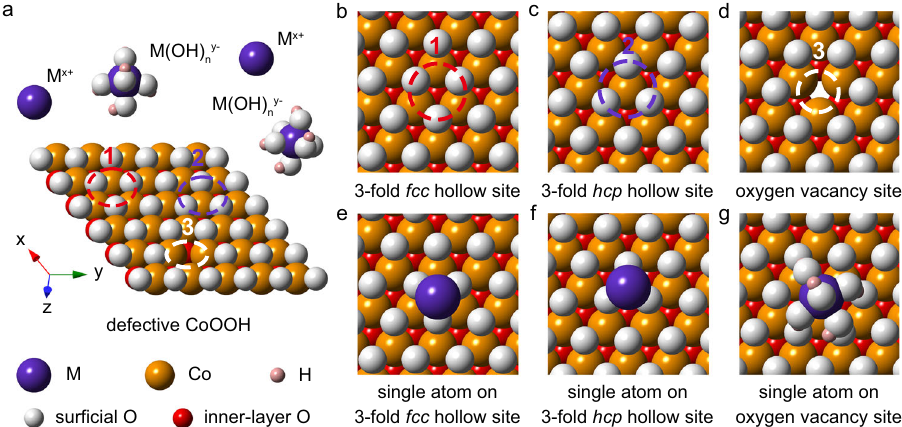
Fig. 1 Scheme of defective CoOOH surface for anchoring single atoms in alkaline solutions. a Oxygen-terminated (001) surface of defective CoOOH with oxygen vacancies. b – d Potential anchoring sites on defective CoOOH, including three-fold (3-fold) fcc hollow site ( b ), 3-fold hcp hollow site ( c ), and oxygen vacancy site ( d ). e – g Single atoms anchored on different surface sites of defective CoOOH. In the aqueous synthesis of SACs, the metal ions are anchored onto the support through electrostatic adsorption. When using an alkaline solution, the metal precursors form both metal cations (M x + ) and metal hydroxyl anions (M(OH) n y − ). Due to their different electronegativities, the positive M x + ions are inclined to adsorb on three-fold hollow sites ( e , f ), while M(OH) n y − ions are prone to anchor onto oxygen vacancy sites ( g